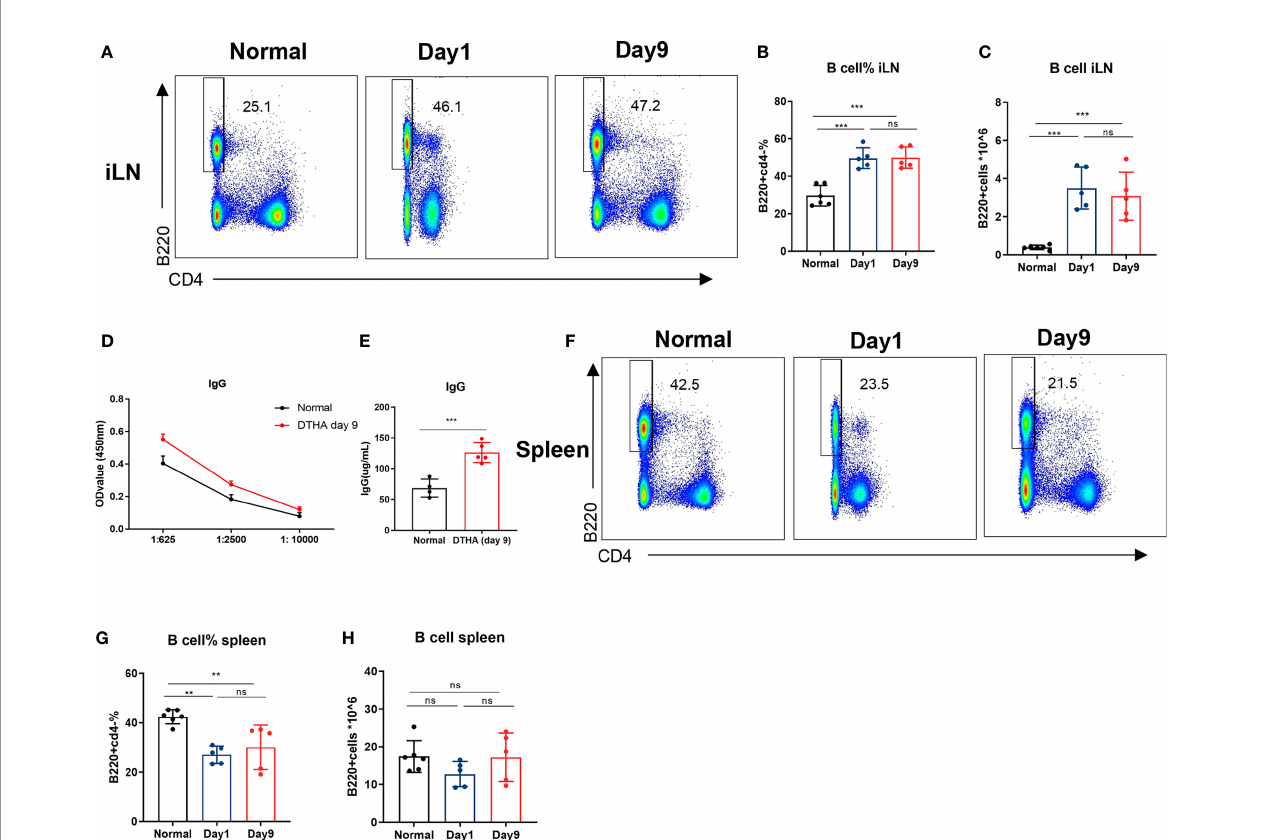
FIGURE 5 | B cell levels increase in draining lymph node but not spleen in DHTA mice. Cells were prepared from the draining iLN and spleen of DTHA-induced and normal mice on day 1 and day 9 and analyzed by fl ow cytometry. (A) Representative fl ow cytometry dot plot of B cells (B220+CD4 − ) from iLN DTHA and DTHA mice on day 1 and day 9 post mBSA challenge. (B, C) The proportion (B) and absolute number (C) of B in iLN are shown. (D) On day 9, serial dilutions of plasma were analyzed for IgG antibody titers by ELISA from normal mice and DTHA-induced mice. (E) The levels of plasma IgG antibodies (prediluted 1:625) determined by ELISA in mice from each group on day 9. (F) Representative fl ow cytometry dot plot of B cells from spleen in normal mice and DTHA mice on day 1 and day 9 post mBSA challenge. (G, H) The proportion (G) and absolute number (H) of B in spleen are shown. All data are presented as mean ± SD and representative of two independent experiments with n = 3 – 4 in the normal mice group and n = 5 in DTHA group per experiment. Statistical signi fi cance was calculated by Student ’ s t-test for the comparison of two mouse groups (***p < 0.001). For the comparison of three groups, statistical signi fi cance was calculated by ANOVA with Tukey multiple comparison test (**p < 0.01, ***p < 0.001, ns: p > 0.05). ELISA, Enzyme-linked immunosorbent